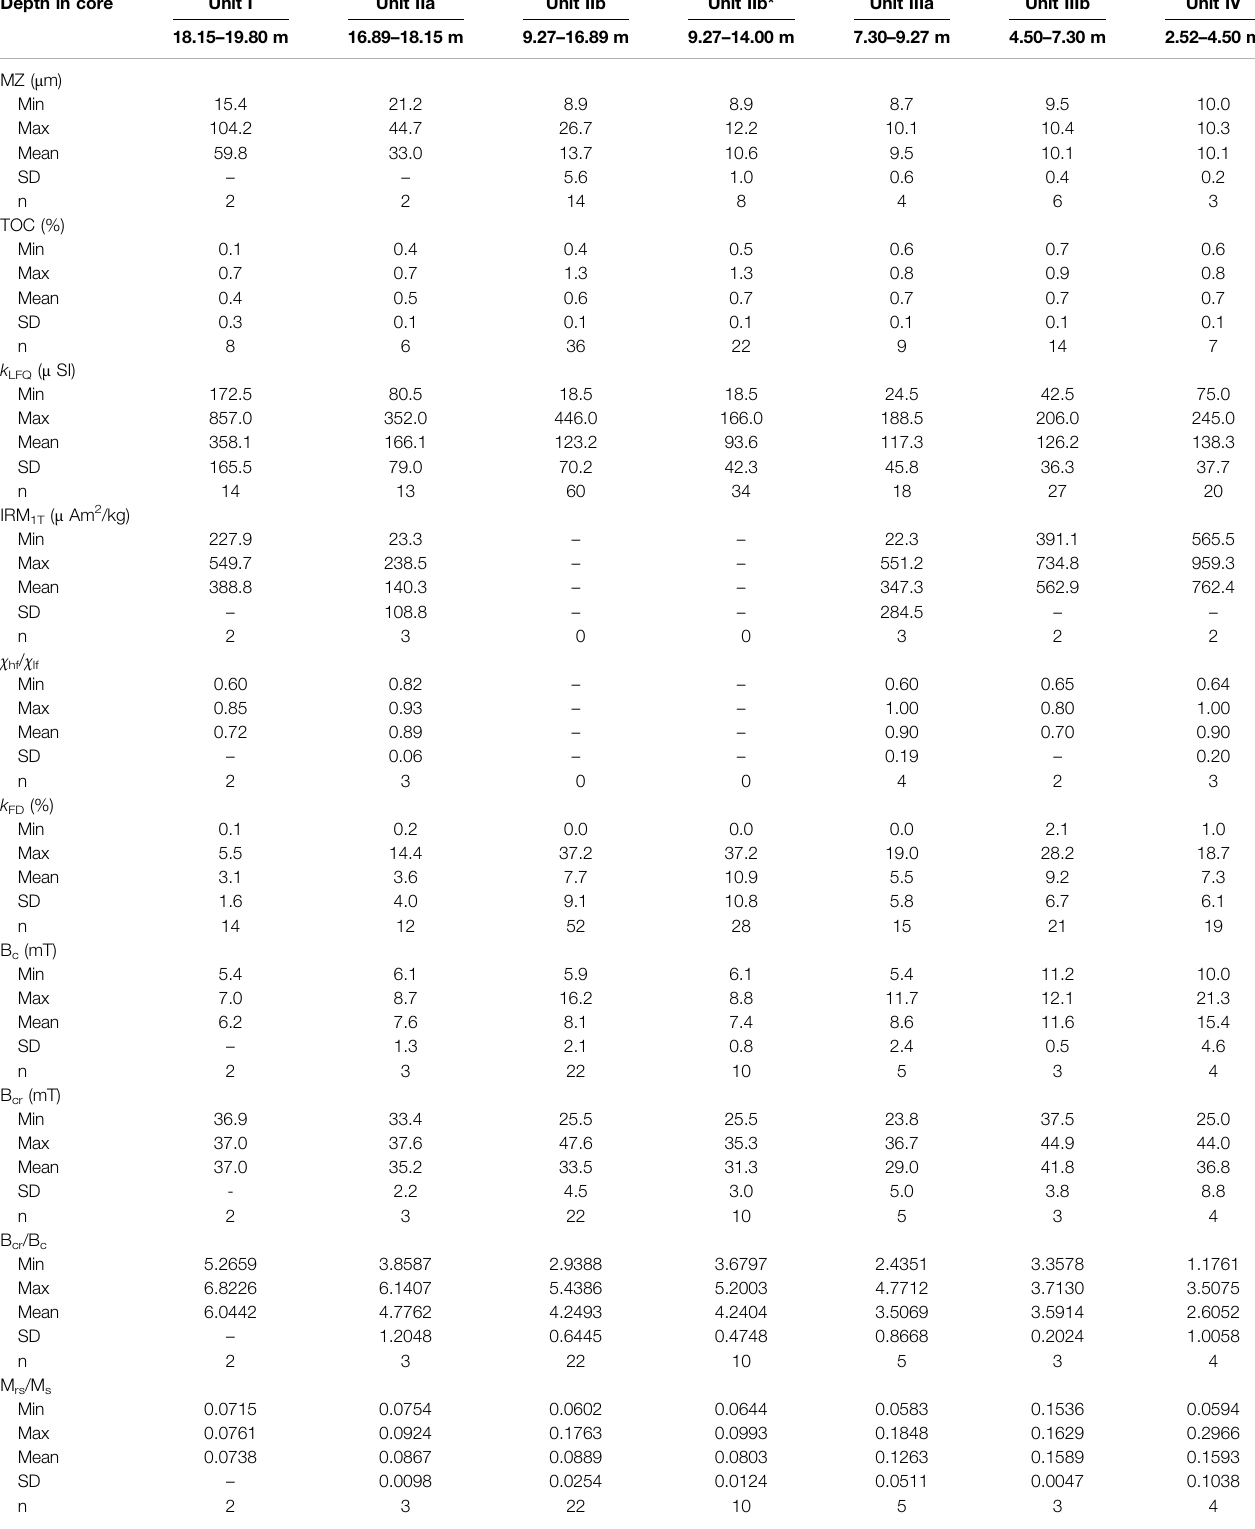
TABLE 2 | Summary statistics of mean grain size (MZ), total organic carbon (TOC) content, and various bulk magnetic properties from the YAR04 core sediments (the YeongsanEstuary).Notethatcalculationsof k FD statisticsweremadeusingonlythe k FD valuesofnolessthanzero,forconveniencewithaconsiderationoftheexclusion of unrealistic values presumably due to measurement errors. Depth in